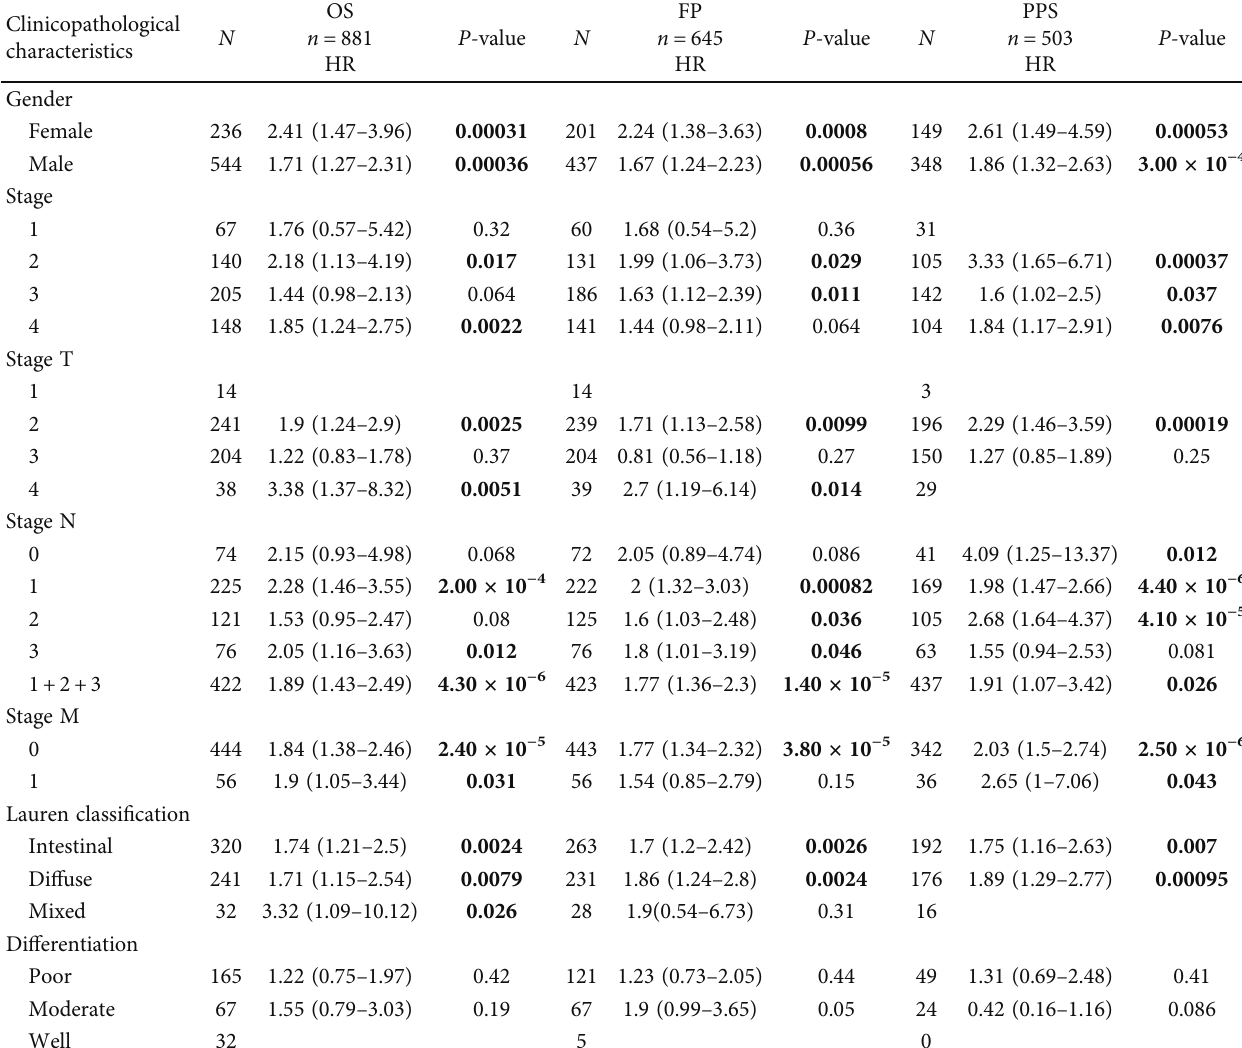
Table 2: The correlation of ZNF521 mRNA expression and clinical prognosis in gastric cancer with di ff erent clinicopathological factors by Kaplan – Meier